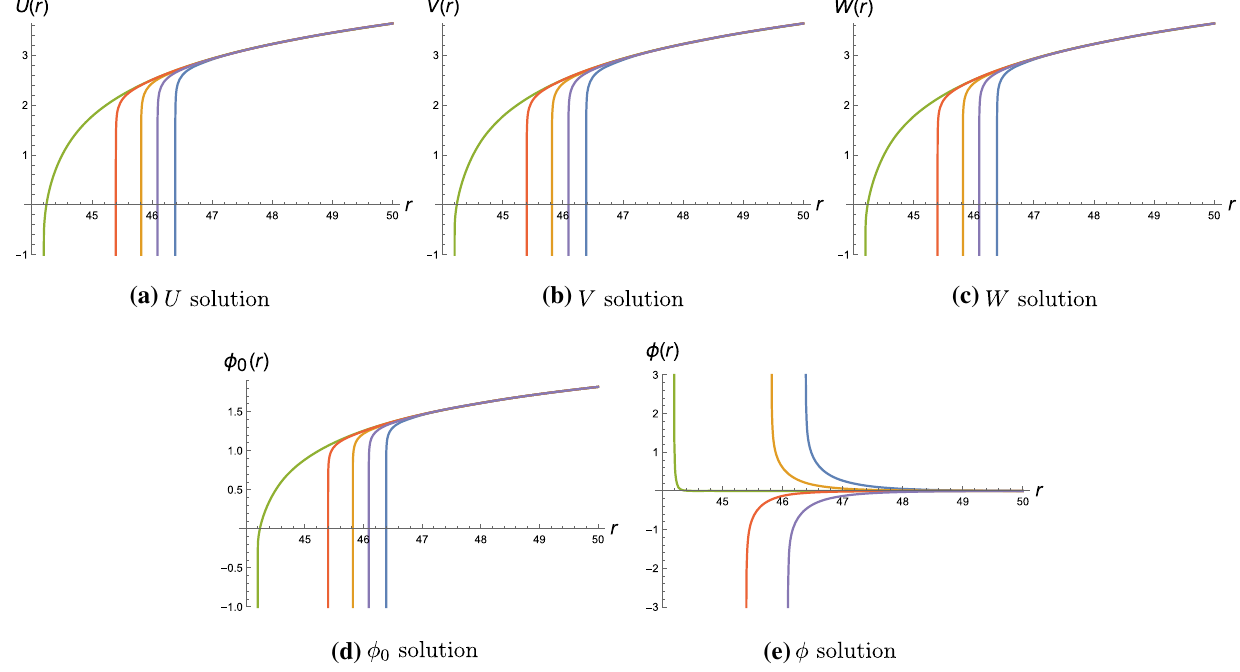
Fig. 41 Supersymmetric flows interpolating between asymptotically locally flat domain walls and Mk w 2 × R 2 × R 2 -sliced domain walls in SO ( 4 ) gauge group. The blue, orange, green, red and purple curves refer to p 21 = − 0 . 5 , − 0 . 12 , 0 , 0 . 03 , 0 . 25,